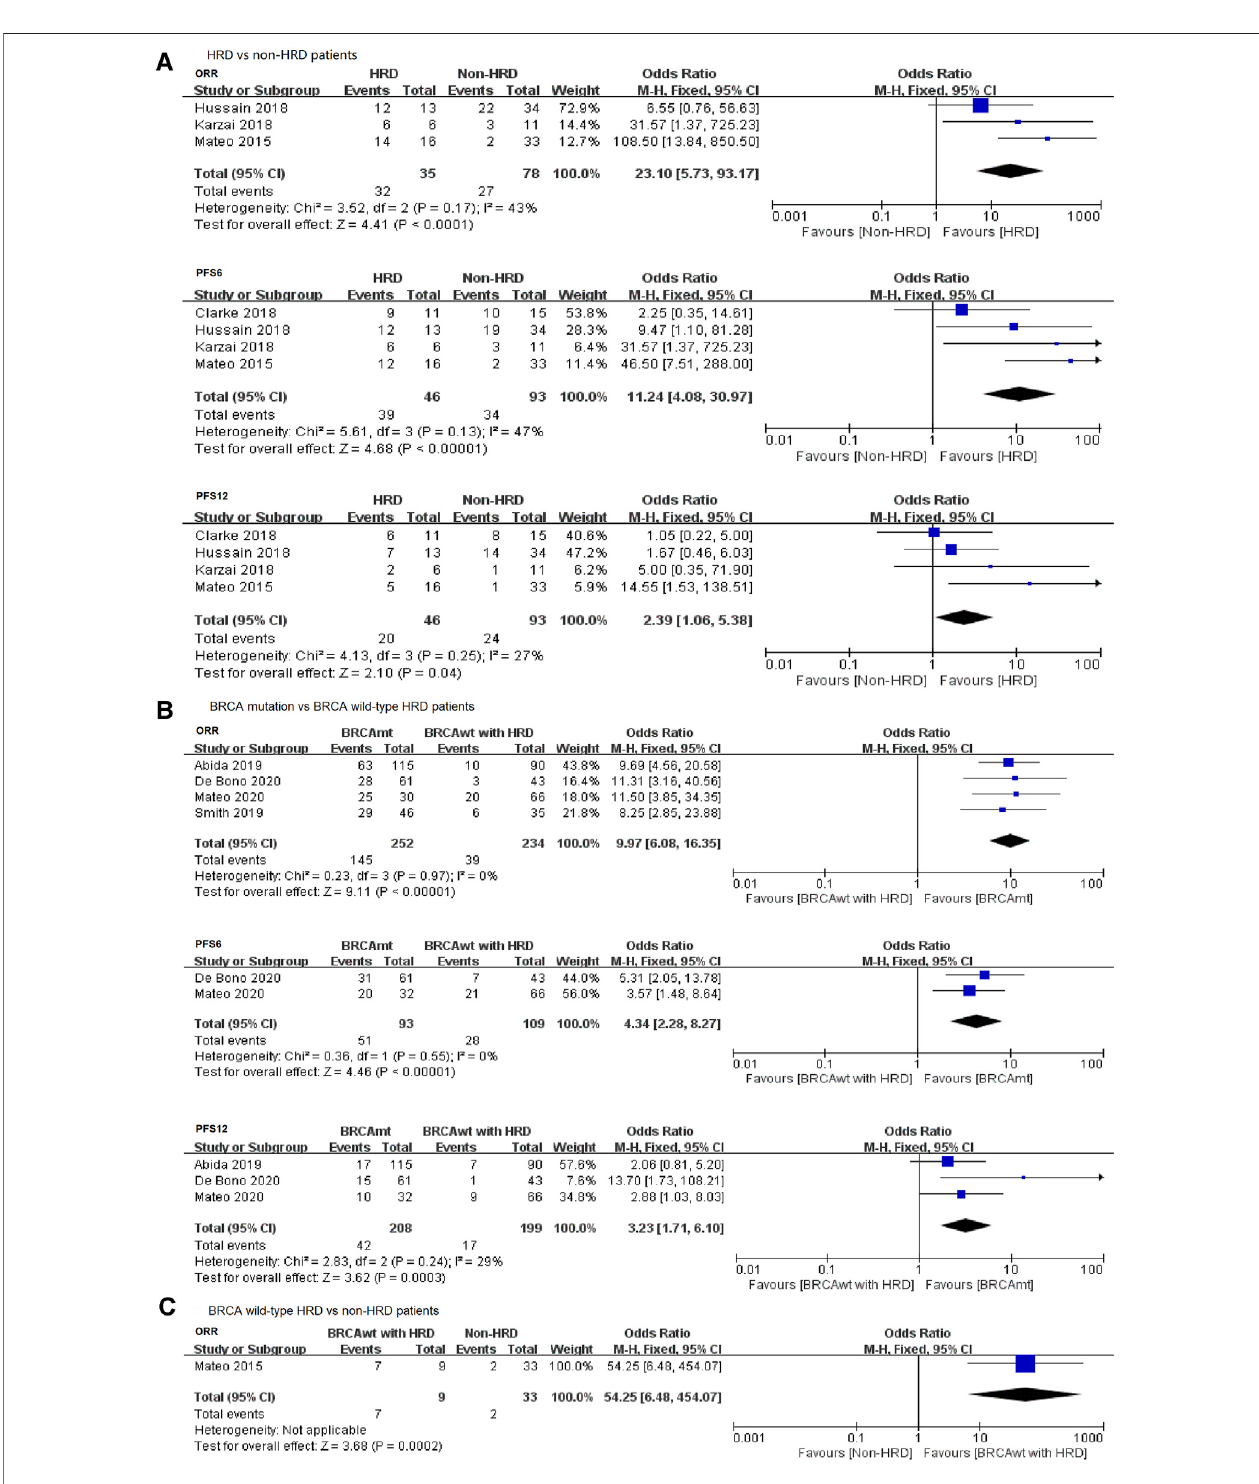
FIGURE3| ForestplotsofpooledanalysesfortheeffectofPARPinhibitorsonORRandPFSin (A) HRDvs.non-HRDpatients, (B) BRCA mutationvs. BRCA wild- type HRD patients, and (C) BRCA wild type with HRD vs. non-HRD patients.